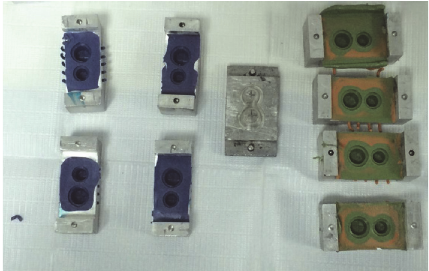
Figure 3: Polyether and putty reline impression made in custom